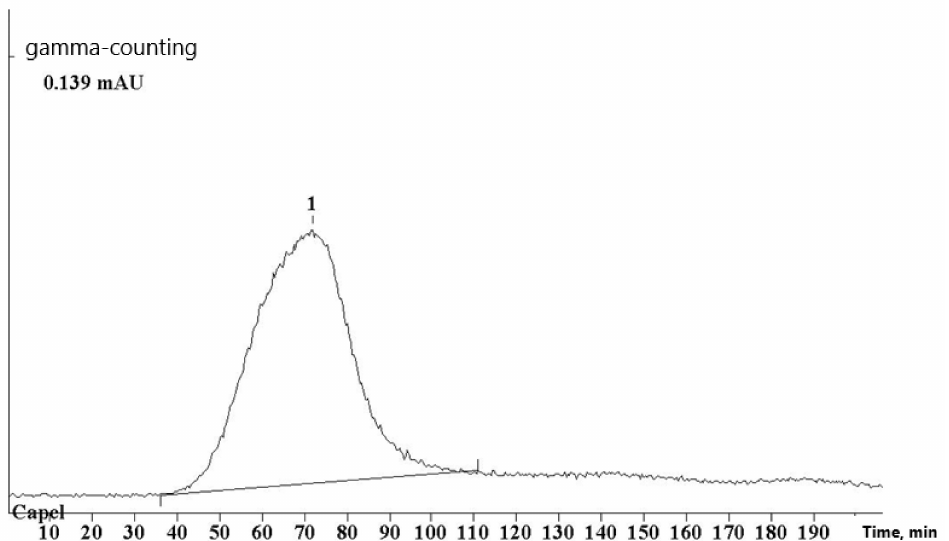
Figure 5. Isolation of VP-VFA-VIDA- 68 Ga with Sephadex G-25 superfine sorbent by gel filtration. Sample volume: 0.5 mL; eluent: 0.9% NaCl; time, min. Radiochemical yield of the target product: 80% (calculated using Equation (1)). Peak 1: VP-VFA-VIDA- 68